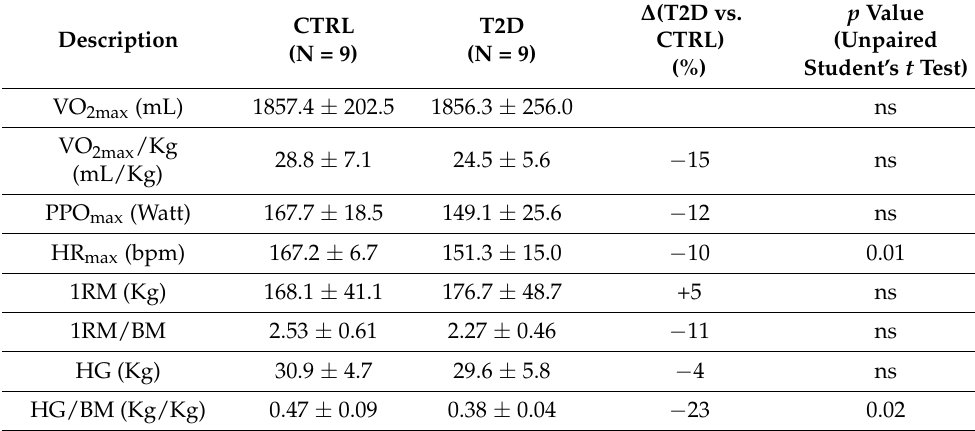
Table 3. Values of cardiorespiratory fitness (CPET test) and strength parameters (1RM and HG). The following parameters were considered: maximal cardio-respiratory capacity (VO 2max ) , peak